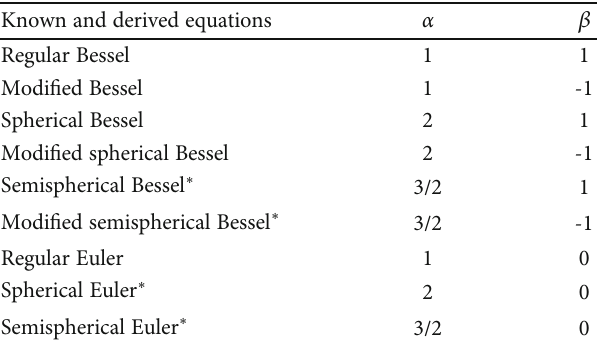
Table 1: Bessel and Euler equations.